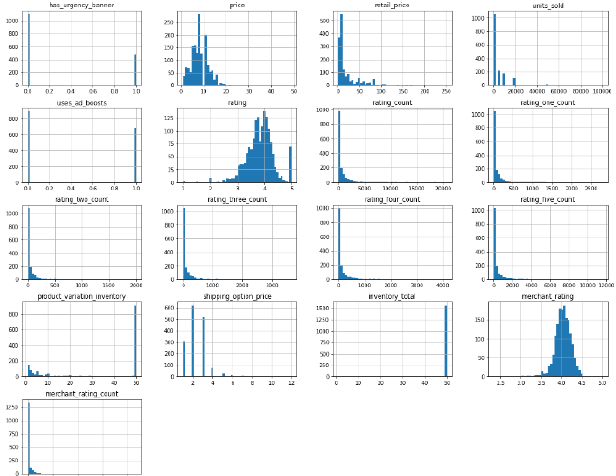
Fig. 3.1 Column wise Distribution of